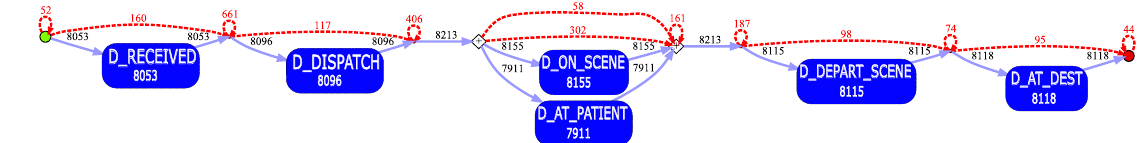
Figure 6. Process model of Cohort